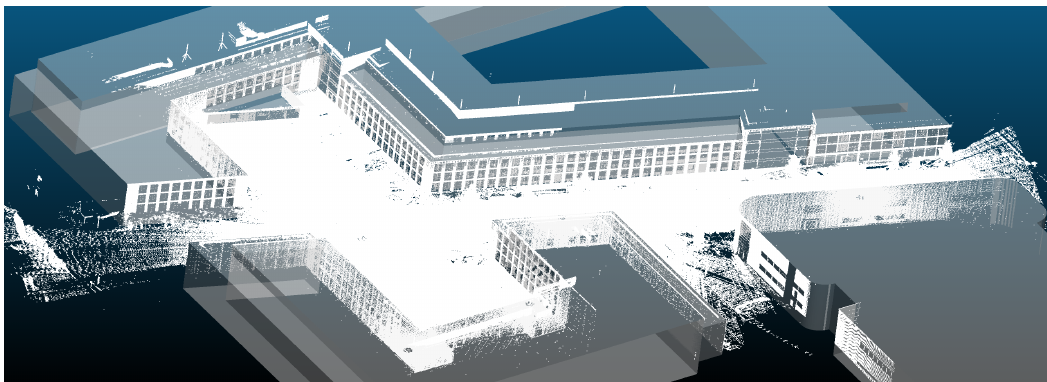
Figure 7. Captured scene of the Poppelsdorf campus of the University of Bonn. Acquired point cloud based on our planned standpoint network and navigation path matched with a precise authoritative LoD2 model of the surrounding buildings.